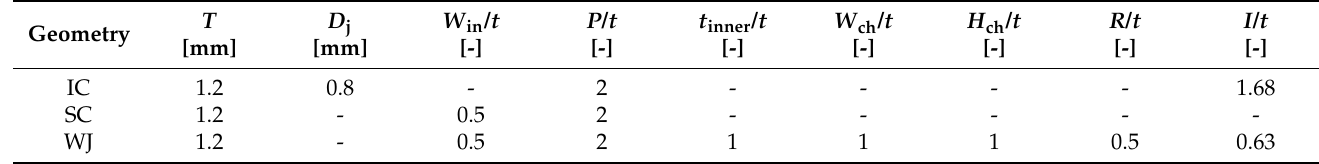
Table 1. Detailed geometric parameters of the internal cooling structures.